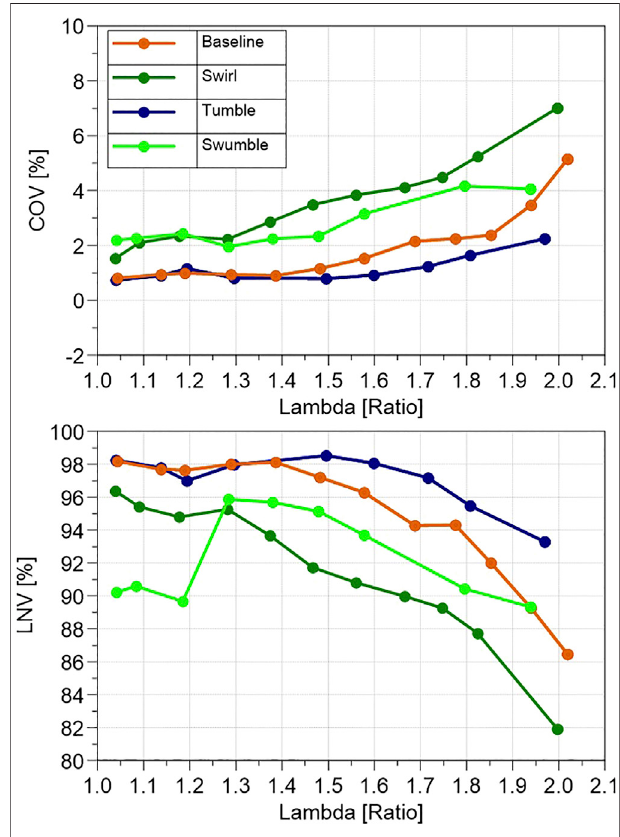
FIGURE 5 | Combustion stability metrics vs. lambda; 1,500 rpm, 6 bar BMEP, angle of 50% fuel mass burned (CA50) (cid:1) 8 ° after TDC.